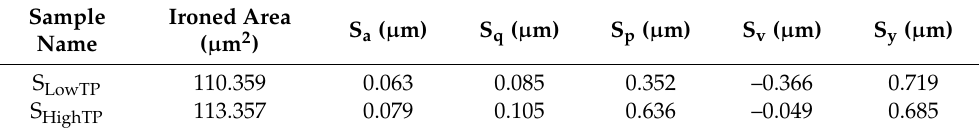
Table 3. Calculated values from AFM images—Average roughness (S a ), Mean square root roughness (S q ), Maximum peak height (S p ), Maximum valley depth (S v ), and Maximum peak-to-valley height (S y )—for S LowTP and S HighTP